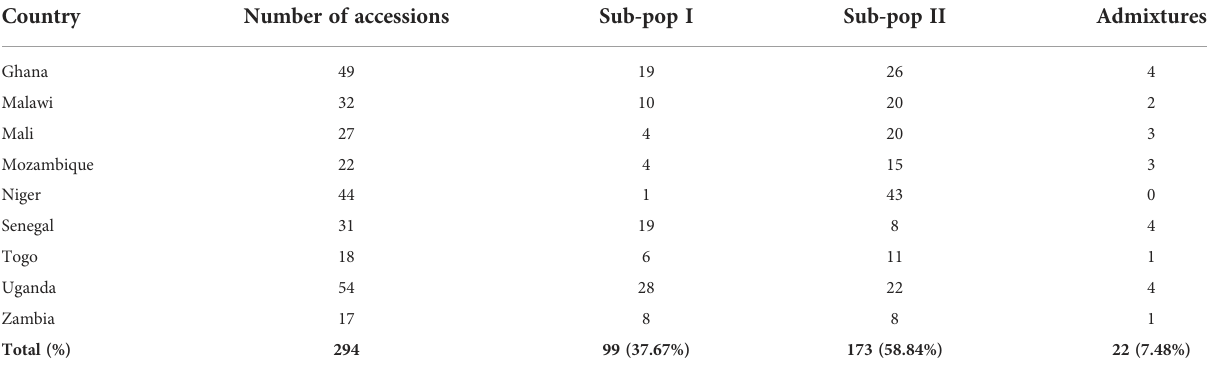
TABLE 3 Population strati fi cation based on membership coef fi cient (Q) from the STRUCTURE software.